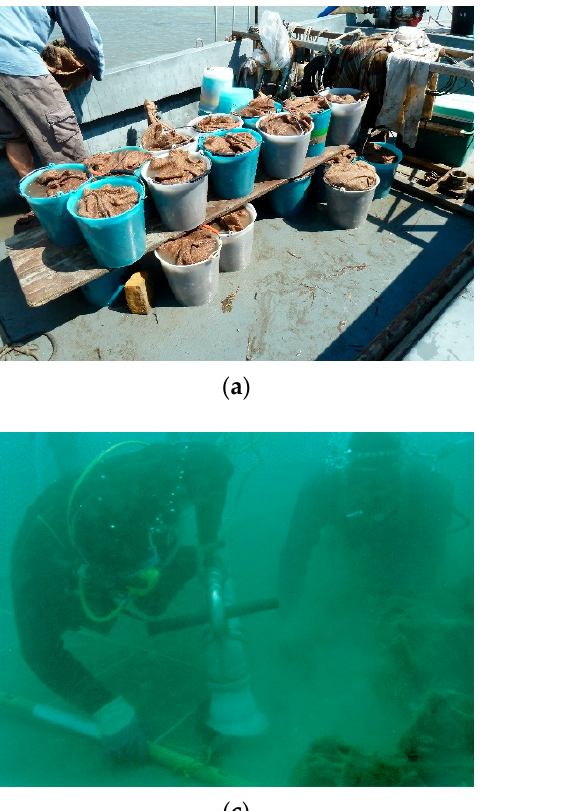
Figure 8. The sods positioning design: on the left, regular, and on the right, with cores. The sods, with a diameter of 22 cm and a height of 25 cm, after being taken from donor sites with a manual core drill, were placed in plastic pots with jute bags that allowed them to be transported and properly humidified before replantation with boats. A team of scuba divers carried out the transfer of the sods. The positioning design (regular or with cores) as per project was carried out by setting up a mobile frame at the bottom with a specific reference grid.